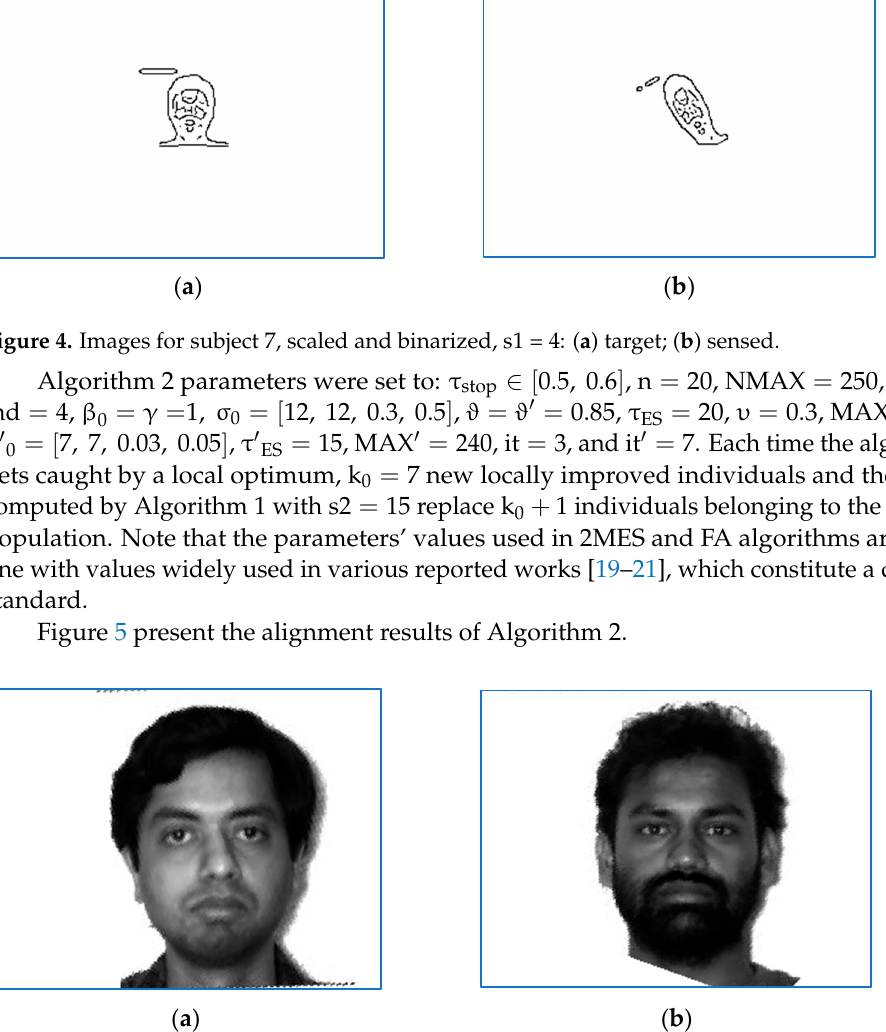
Figure 5. Images registered by Algorithm 2: ( a ) subject 10; ( b ) subject 7.